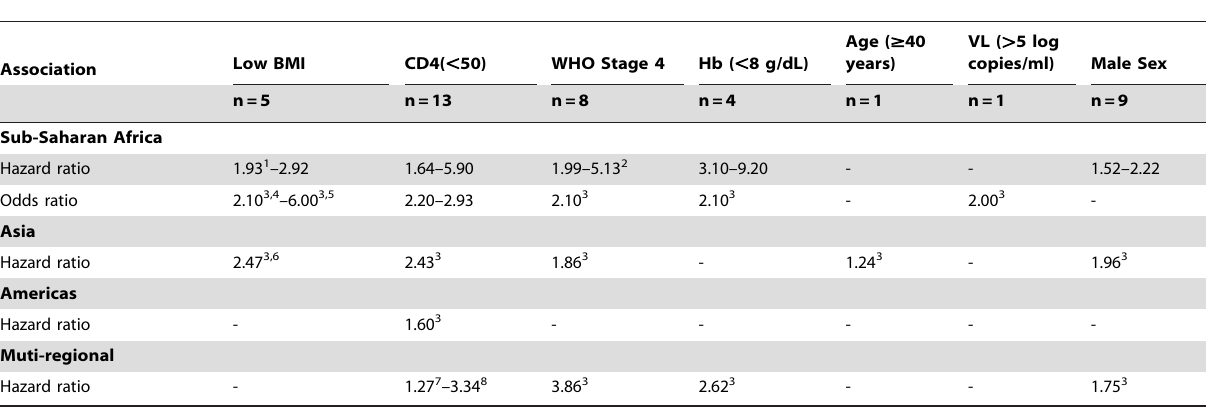
Table 2. Range of hazard and odds ratios of independent risk factors associated with early mortality by region.